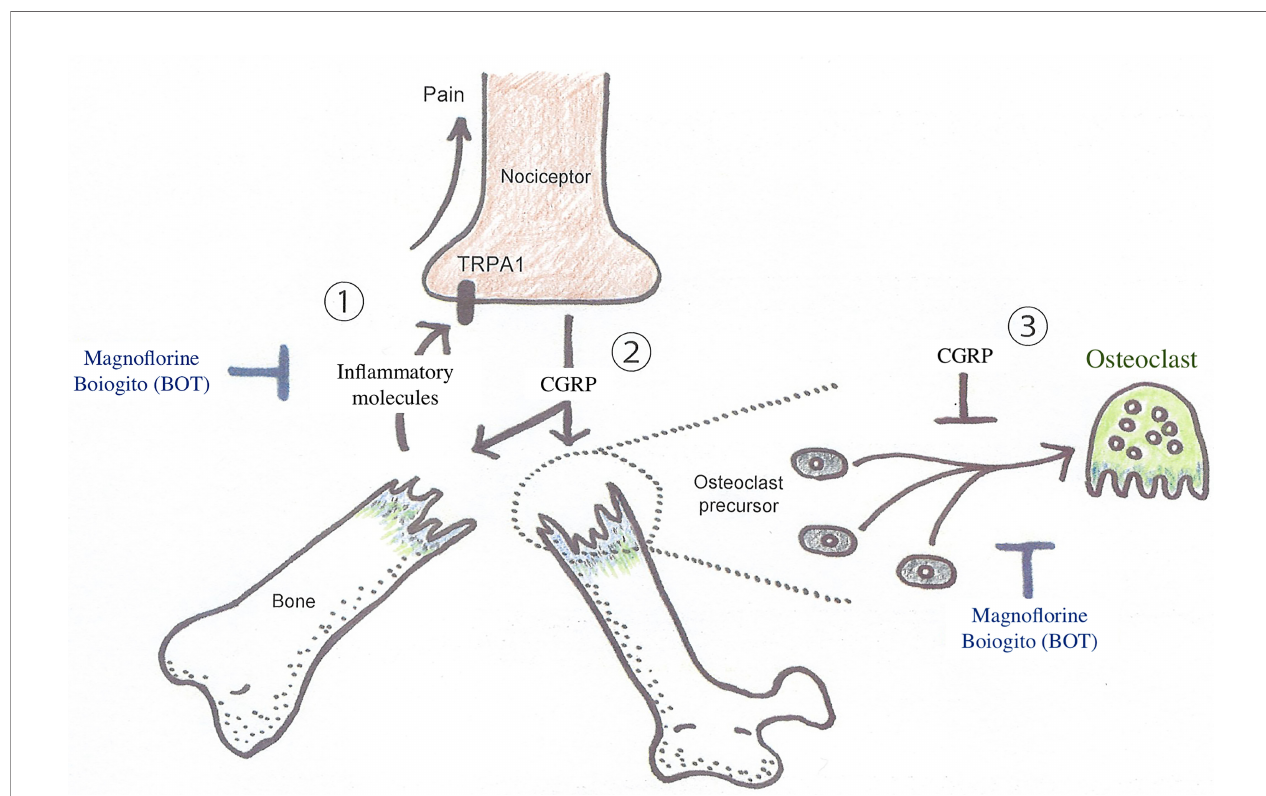
FIGURE 2 | Diagrammatic illustration of the interaction between nociceptive neurons and osteoclasts in abnormal bone metabolism in CRPS triggered by trauma, such as the fracture of an extremity. A substantial injury, such as a bone fracture, produces action potentials in nociceptive neurons via TRPA1 activation, which transmits painful stimuli. On the other hand, osteoclast differentiation is inhibited when CGRP is released around the injured site via retrograde axonal transport and exocrine secretion. However, there is concern that the in fl ammatory response triggered by CGRP spreading around the injured tissue may lower the threshold for depolarization of many other nociceptive neurons, resulting in peripheral pain sensitization, leading to the CRPS development. Boiogito, which is rich in magno fl orine, is expected to prevent the exacerbation of symptoms and pathological conditions of early CRPS by inhibiting osteoclast differentiation and in fl ammation. CGRP, calcitonin gene-related peptides; TRPA1, transient receptor potential ankyrin